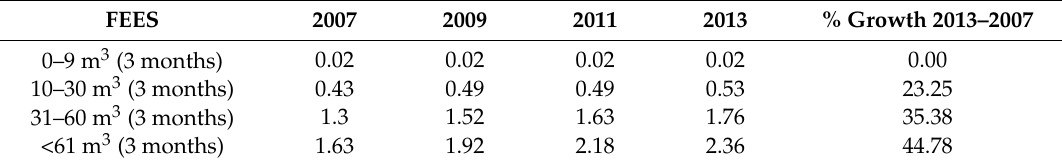
Table 6. Evolution of the water price by consumption blocks ( € /m 3 ), 2007–2013. Source: AMAEM. Elaborated by the